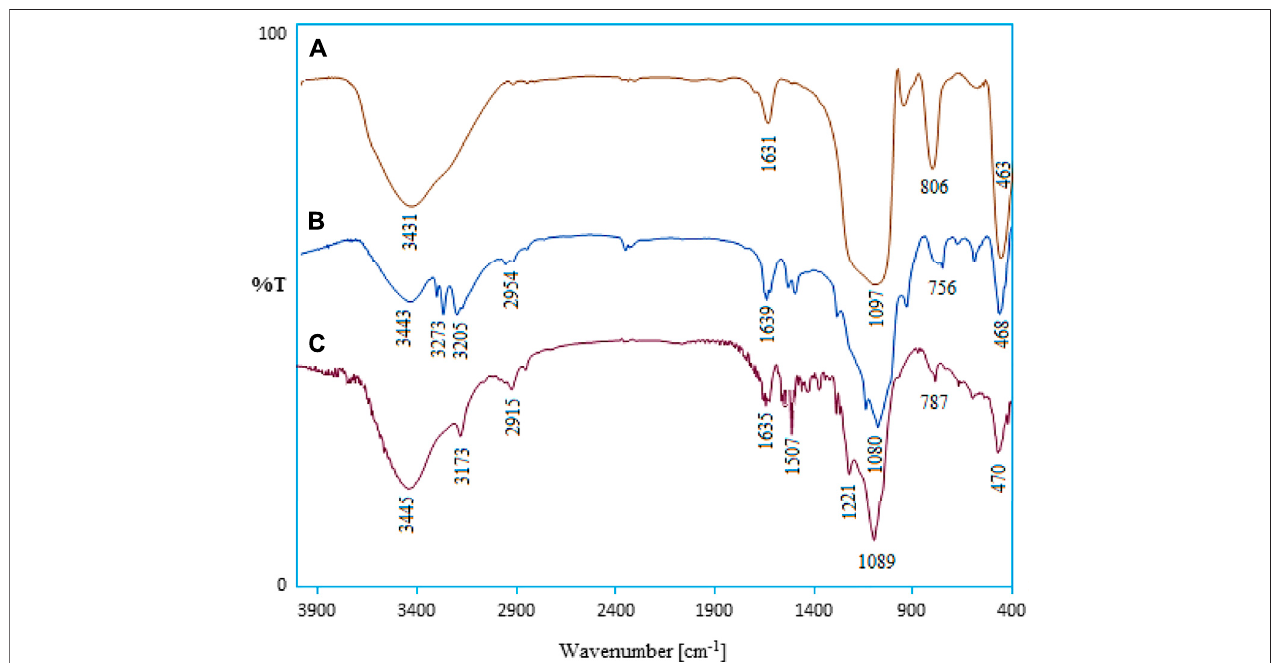
FIGURE 1 | FT-IR spectra of (A) SBA-15, (B) SBA-15-TCH, and (C) Pd/TCH@SBA-15.